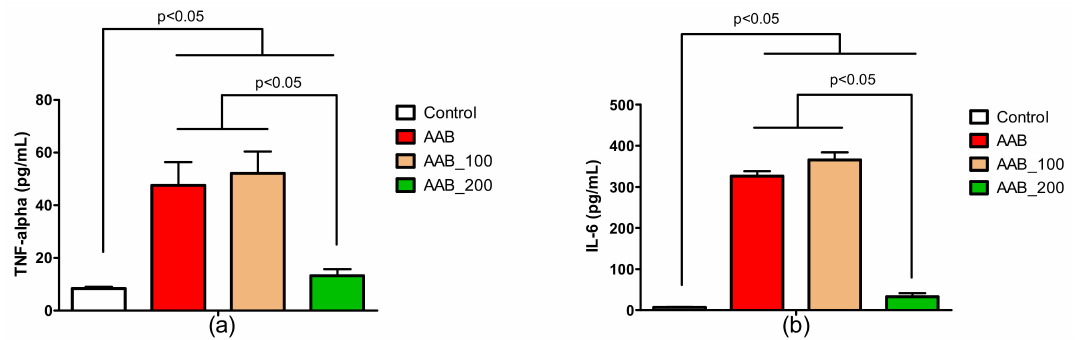
Figure 3. E ff ects of LBPs on cytokines levels at week 36: ( a ) plasma TNF- α levels; ( b ) plasma IL-6